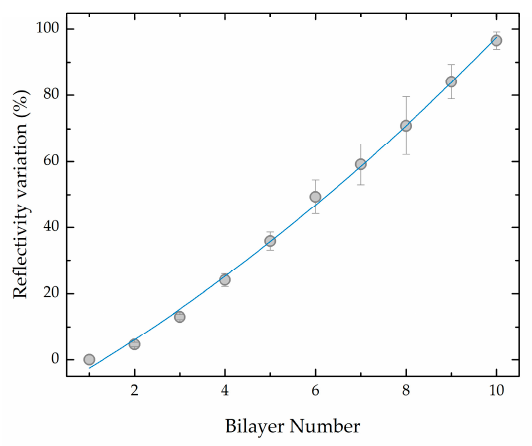
Figure 4. Reflectivity variation with the number of PEI/GO bilayers, for the cleaved fibers.